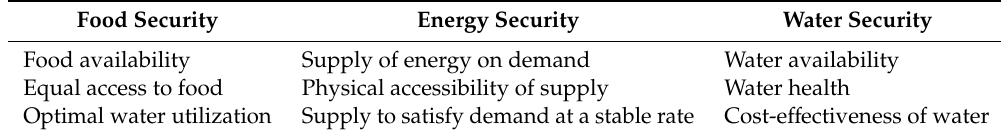
Table 1. Energy, food and water nexus [18] .